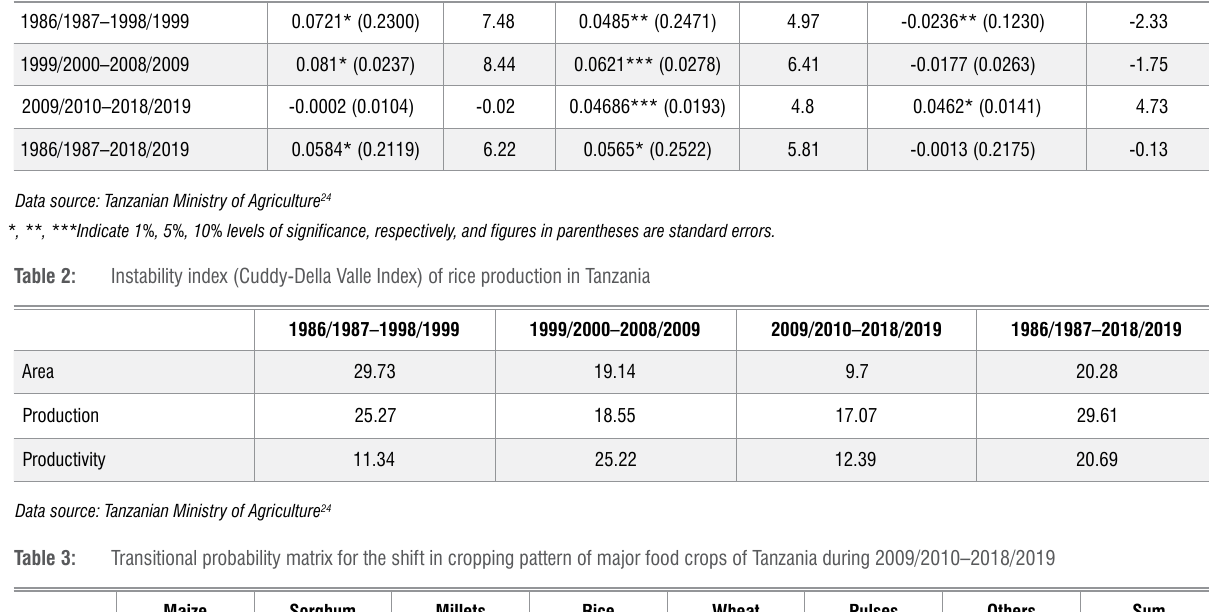
Compound annual growth rate (CAGR) for rice production in Tanzania Period